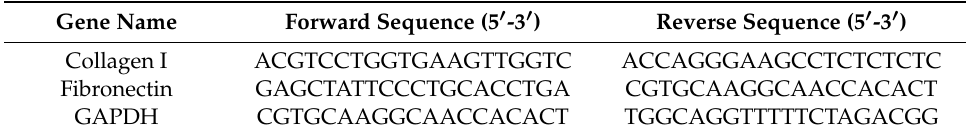
Table 1. Primer sequences for reverse transcription-quantitative polymerase chain reaction.